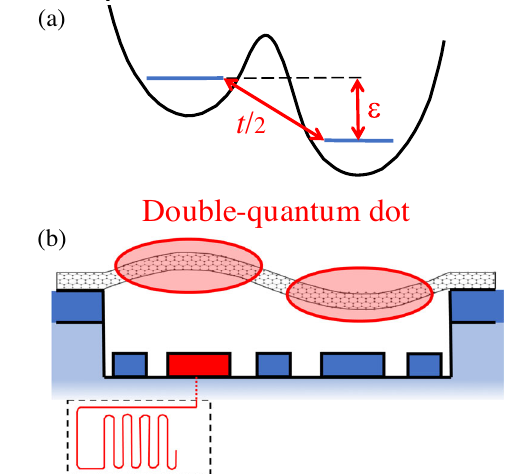
FIG. 1. Schematic of the proposed setup. A suspended carbon nanotube hosting a double quantum dot, whose one-electron charged state is coupled to the second flexural mode. (a) Sketch of the electronic confinement potential and of the two main parameters, the hopping amplitude t and the energy difference ϵ between the two single-charge states. (b) Physical realization. One of the gate electrodes is connected to a microwave cavity for dispersive qubit